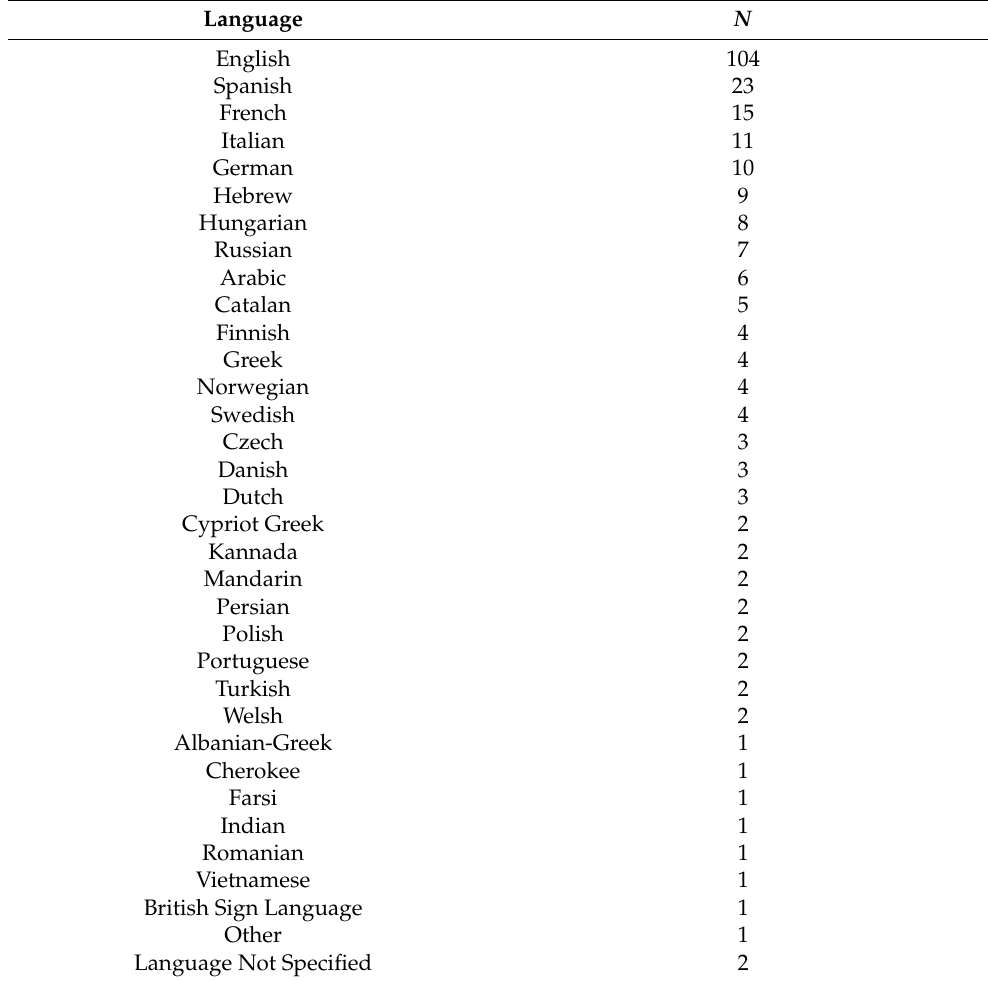
Table 1. Frequency of languages included in the studies published between 2010 and